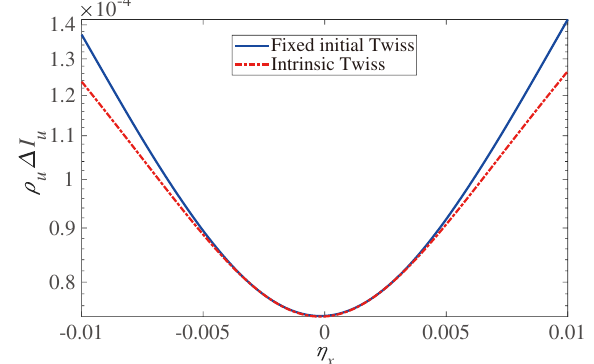
FIG. 8. The contribution coefficient Δ I u to longitudinal emit- tance when the undulator or wiggler is located at a dispersive position. The blue solid line is the result at ð α 0 ; β 0 Þ ¼ ð 1 . 64 ; 114 μ m Þ . For each η β 0 , and the red dashed line gives the optimized result. N ¼ 50 . u